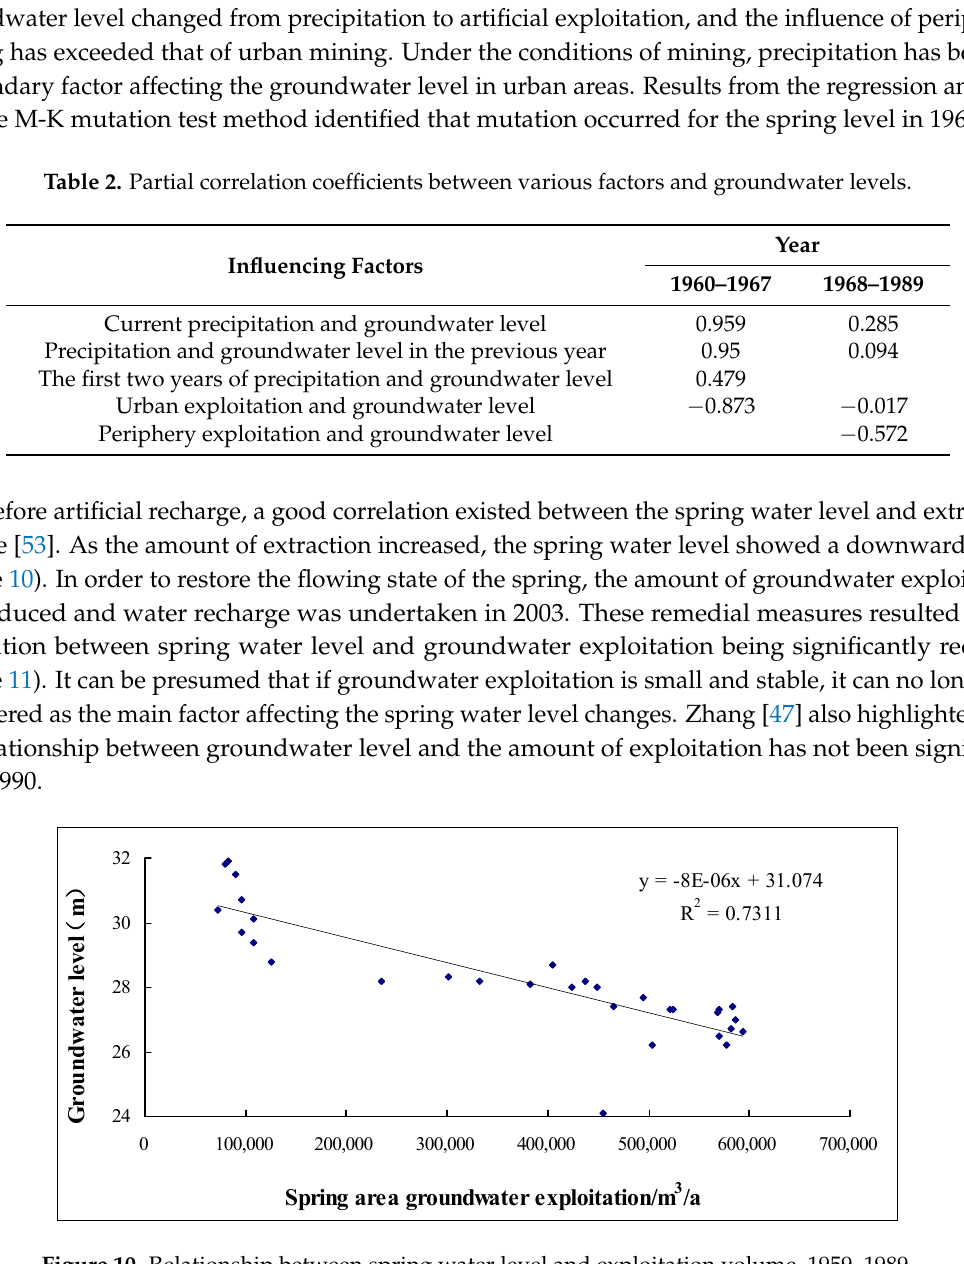
Figure 11. Relationship between groundwater exploitation and spring water level, 2003–2012. M-K trend analysis can not only identify the significant trend of ascending and descending atmospheric precipitation and spring water series, it can also highlight the moment of mutation. However, the influencing factors of precipitation and water level are complex. Groundwater exploitation size, precipitation, rainfall station location and artificial recharge amount all have an impact on groundwater dynamics. Therefore, if M-K is used to analyze the characteristics of the catastrophe year and establish an appropriate prediction model, this will enable an improvement in accurately predicting future groundwater level changes. This is consistent with the results of Damir [54], which showed that the effects of spatial and temporal variations of hydrological time series and the space–time-variant behaviors of the karst system can be separated from the correlation functions. 4. Conclusions Morlet wavelet transform for precipitation and groundwater table time series results in the Jinan spring area showing that there are numerous time-scales. The large time-scale includes the small time-scale, and the different time-scales imply different laws of change. Four time-scale